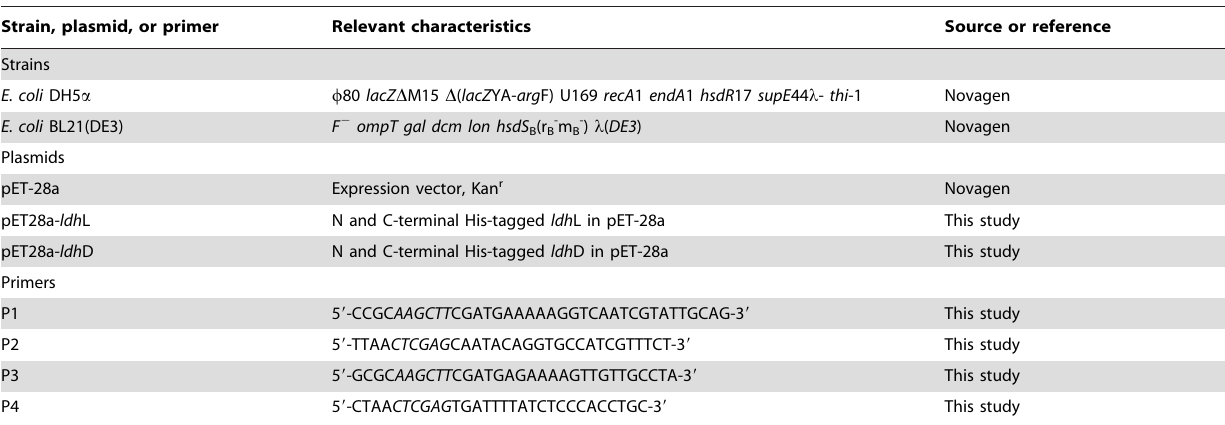
Table 4. Strains, plasmids, and primers used in this